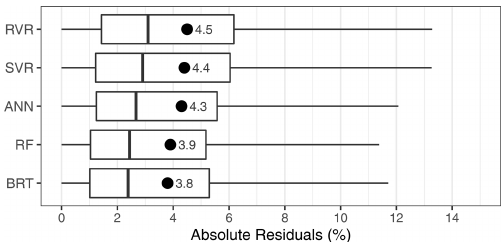
Figure 6. Distribution of residuals and MAE on the testing set by the type of machine learning algorithm. Filled circles and values to the right indicate the average